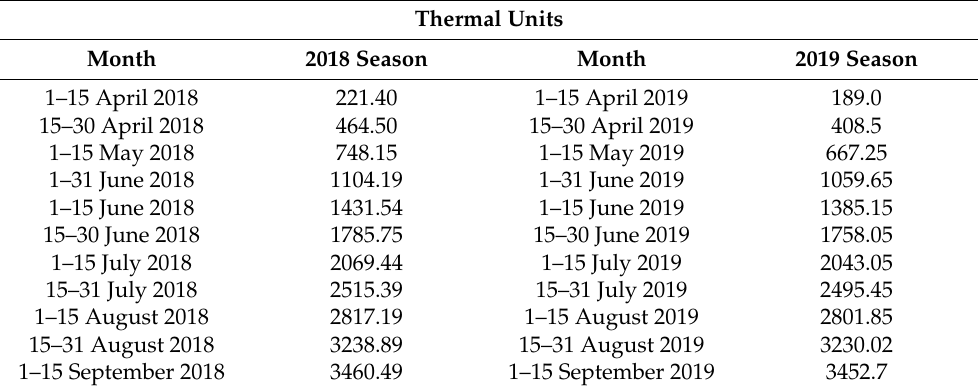
Table 3. Growing degree days (thermal units) through the trial period at Fayoum, Egypt, in 2018 and 2019